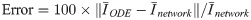
Comparison between risk-structured mean-field results and stochastic network simulations for SIS infection dynamics.The error is the relative percentage error between the risk-structured mean-field model (Supporting Information) and network simulation results for the mean prevalence of infection: Error=100×‖I¯ODE-I¯network‖/I¯network. The degree distribution obeys P(k) = ρ exp(−α(k − K)2) for all k ≥ 2, where α and K are determined to give a desired mean and variance, and ρ is a normalising constant. Other methods of generating degree distributions give similar results. We insist on k ≥ 2 (for all nodes) as this generally ensures that the majority of network form a single giant component. The network is formulated using the Molly-Reed algorithm [47] with 100,000 nodes, but ensuring that there were no self-contacts and no multiple connections between individuals. We assume the recovery rate of individuals γ is scaled to be one, while the transmission rate across a contact scales with the mean number of contacts, τ=2/k¯. As such, the mean prevalence in both simulation and ODE models lies between 30 and 50%.